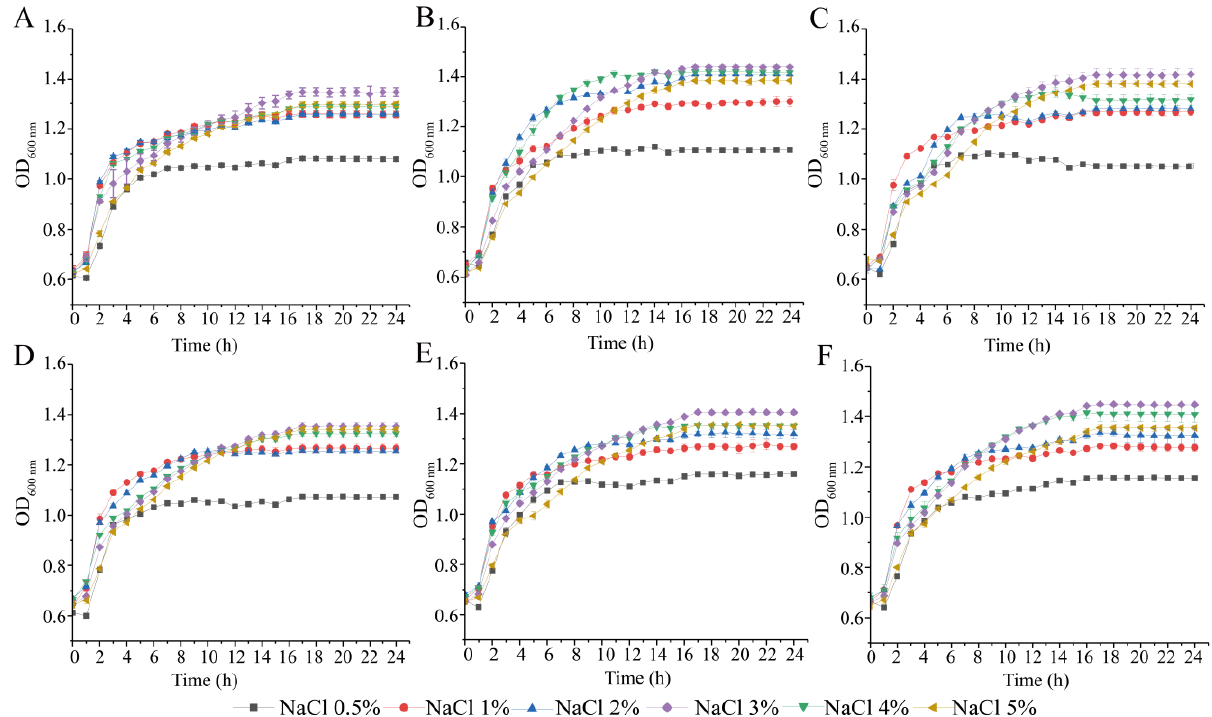
Figure 2. Survival of six V. parahaemolyticus isolates under different concentrations of NaCl. The isolates were incubated in TSB medium (pH 8.5) at 37°C. ( A – F ): V. parahaemolyticus L7-7, N1-22, N3-33, N4-46, N8-42, and Q8-15, respectively.